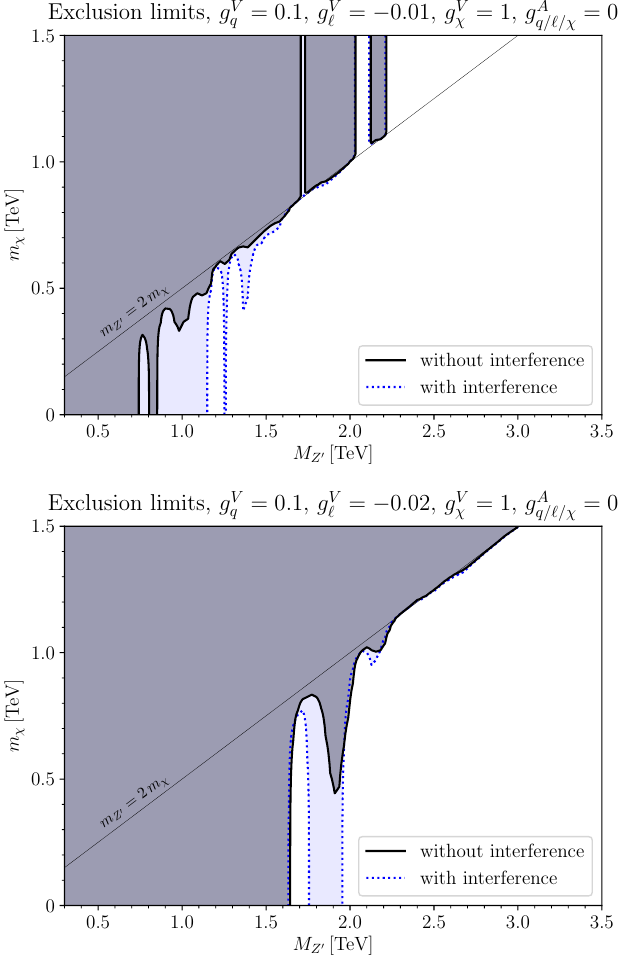
Figure 8 . Same as (cid:12)gure 5 but for the case that g V